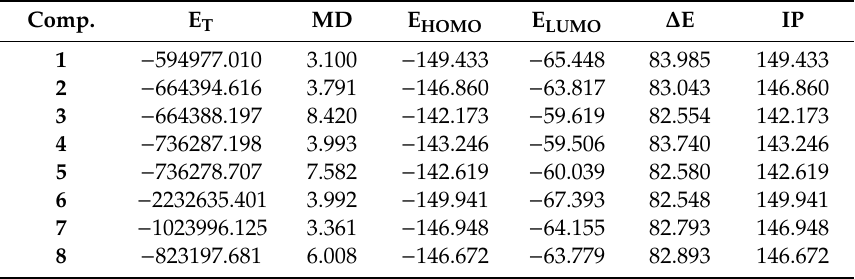
Table 4. Total energy, E T (kcal/mol.), dipole moment, MD (D), energy of HOMO, E HOMO , and LUMO, E LUMO , orbitals (kcal/mol), Δ E = E LUMO -E HOMO (kcal/mol) and ionization potential, IP (kcal/mol), for 1 – 8 calculated at DFT/B3LYP/6-311++G(d,p) level. Comp.